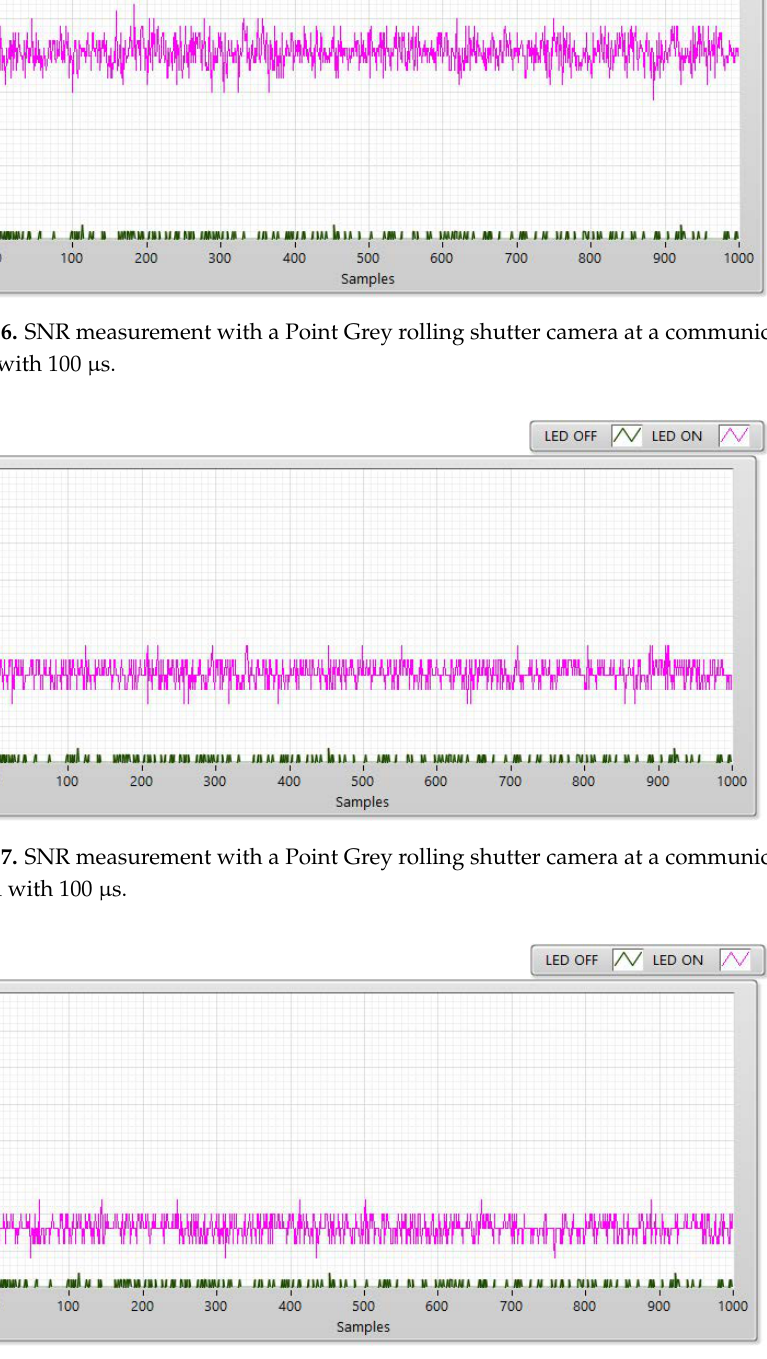
Figure 9. SNR measurement with a Point Grey rolling shutter camera at a communication distance of 20 m with 100 µs.